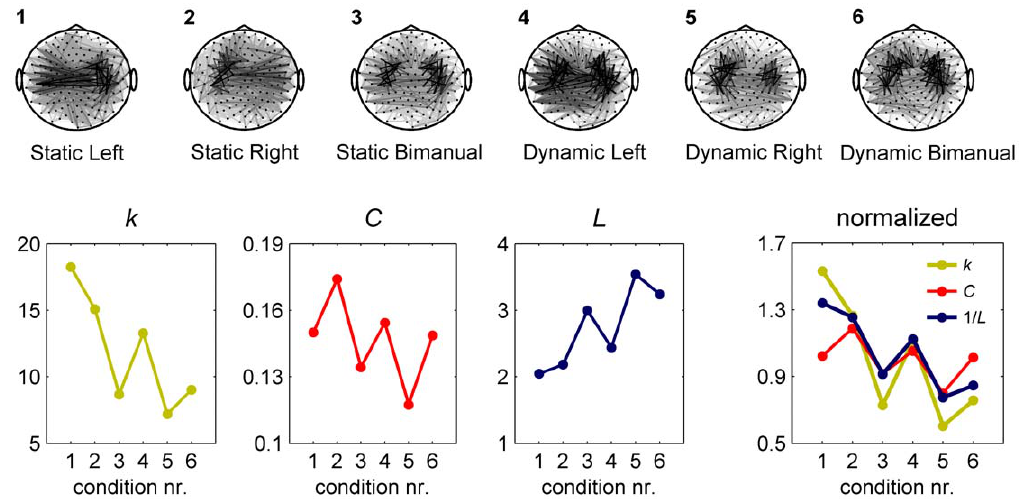
Figure 1. Differences in average degree between empirical networks may influence graph measures. The data here are taken from an MEG experiment we conducted in which participants performed a precision grip force in six experimental conditions that differed in the force pattern exerted (static or dynamic) and hand used (left, right, or bimanual). The topographies show the relative phase uniformity (15–30Hz) between all MEG sensor combinations that is increased compared to resting state. The gray scale indicates the connectivity strength, with stronger connections in darker colors. Results are averaged over 3 6 40s steady state force production and 20 participants. Lower panels: although the clustering coefficient ( C ) and path length ( L ) show clear differences between conditions, these effects co-vary with differences in average degree ( k ). This can be seen more clearly in the right plot where values are divided by the average for each measure and L is inverted. It is difficult to disentangle true experimental effects from those introduced by differences in k because the exact dependence of C and L on k is unknown.